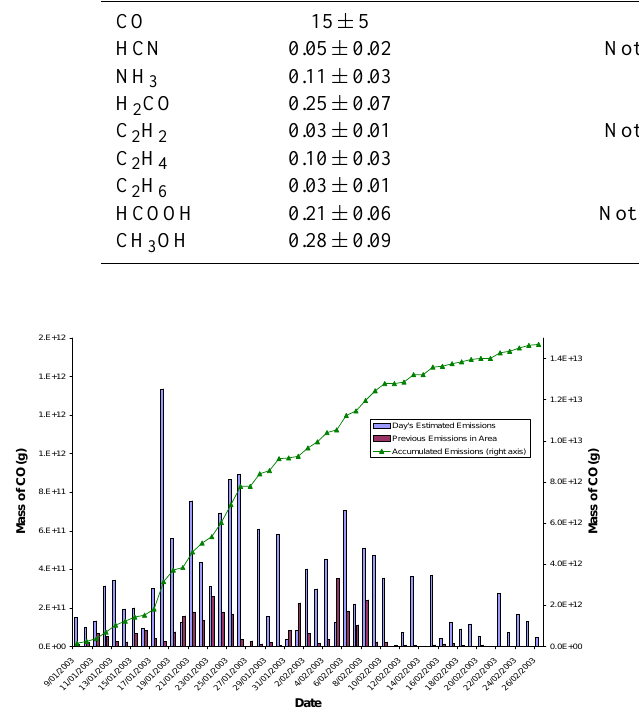
Fig. 3. The estimated emissions of CO for each day are shown alongside the previous 3 days’ emissions that still remain in the area as predicted by MOZART. The accumulated total mass of CO emit- ted by the fires is also shown on a separate right-hand